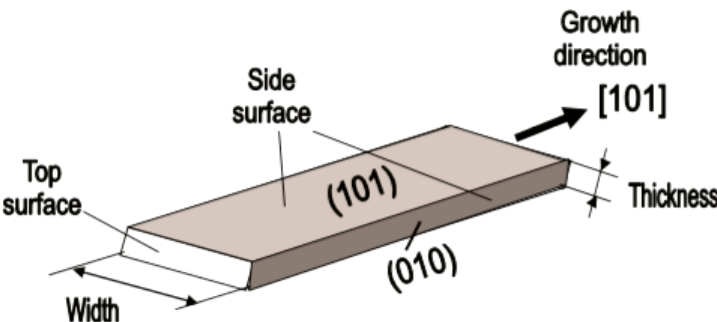
Figure 8. Schematic diagram of the geometric configuration of SnO 2 nanobelts. Reproduced with permission from Korotcenkov [74]. Copyright 2008: Elsevier.